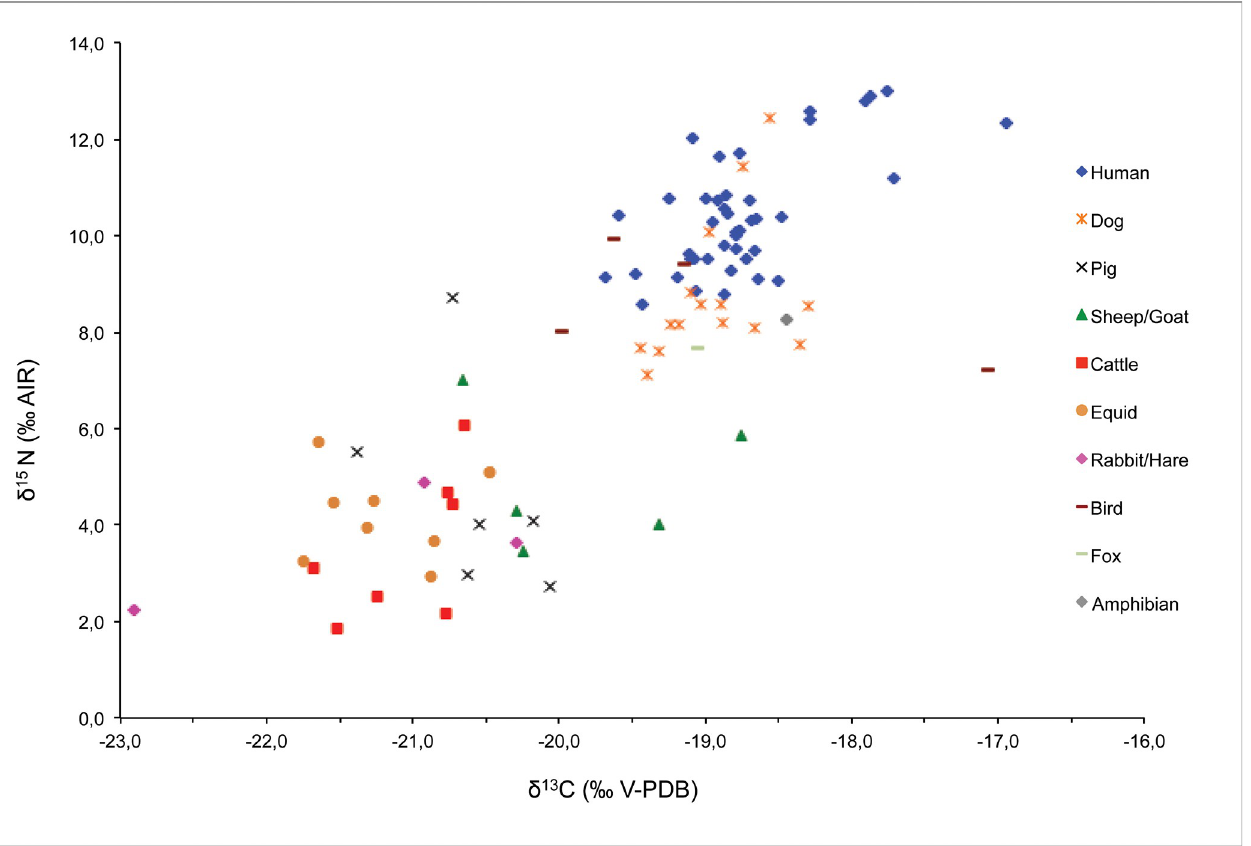
Fig 4. Plot of human and animal bone collagen δ 13 C and δ 15 N values from Vila de Madrid.